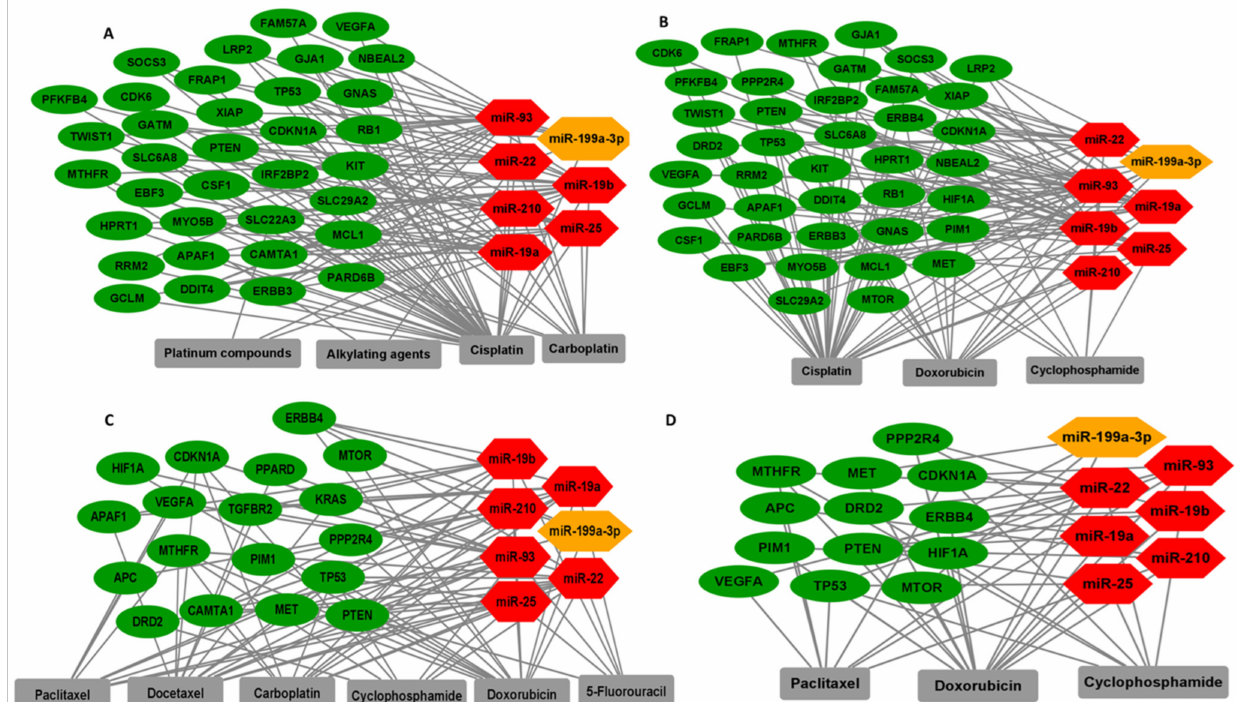
Figure 3. Interactions among different drug combinations for TNBC therapy with significantly upregulated miRNAs (red), downregulated miRNAs (orange), and their target genes (green) for: ( A ) platinum compounds, alkylating agents, cisplatin, and carboplatin; ( B ) cisplatin, doxorubicin, and cyclophosphamide; ( C ) paclitaxel, docetaxel, carboplatin, cyclophosphamide, doxorubicin, and 5-flourouracil (5-FU); ( D ) doxorubicin, paclitaxel, and